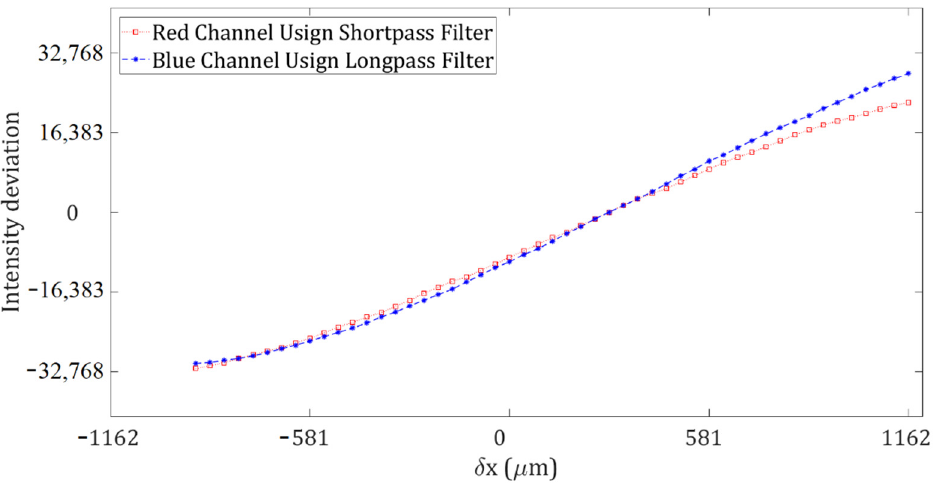
Figure 4. A calibration curve of the red and blue color channels for a particular pixel.